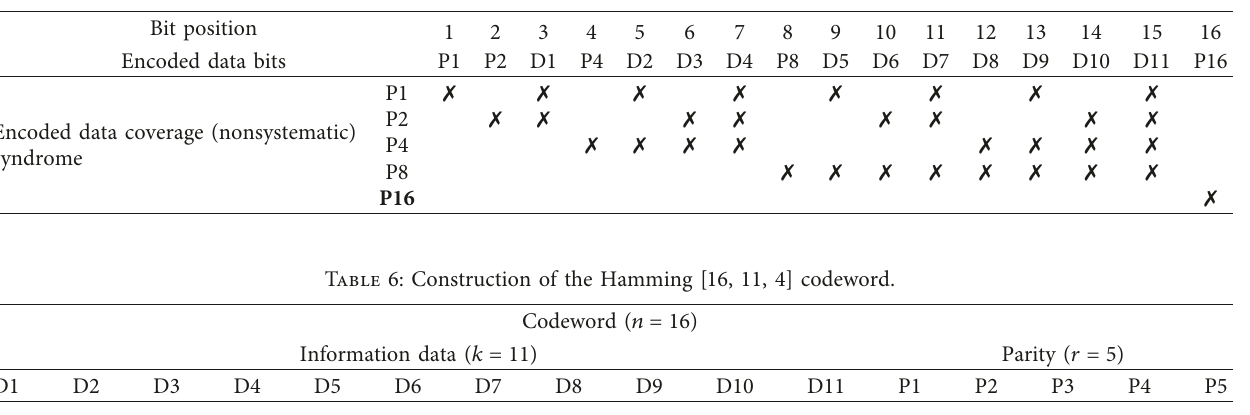
Table 5: Bit layout of extended Hamming code (16, 11).